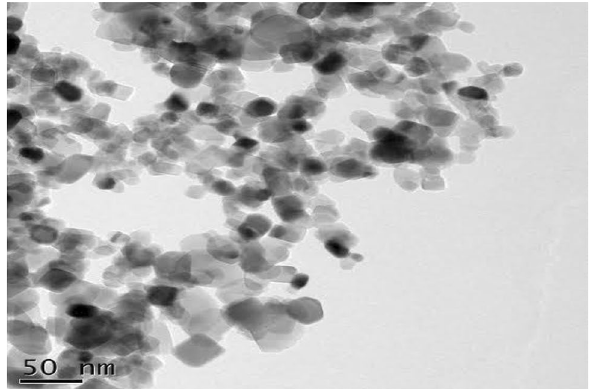
Figure 7. TEM analysis of TiO 2 nanoparticles biosynthesized from Carica papaya shell extracts.